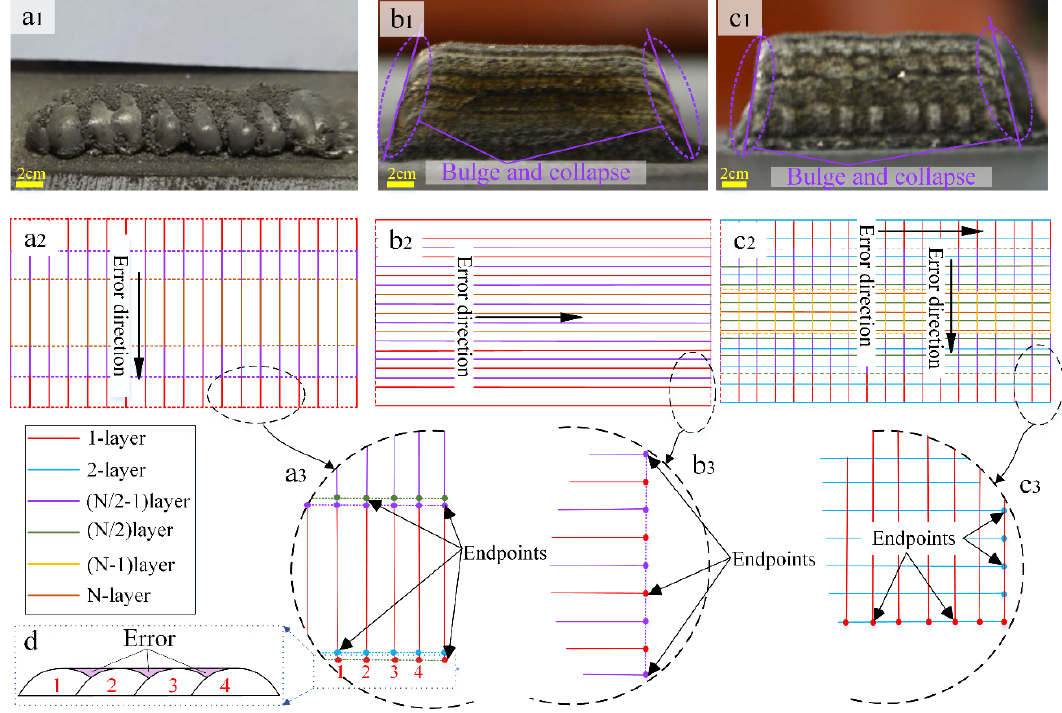
Figure 12. Morphologies of deposition layers under different deposition strategies: ( a ) Strategy III- 1, ( b ) Strategy III-2, ( c ) Strategy III-3, ( d ) Errors owing to incomplete filling. ( b ) Strategy III-2, ( c ) Strategy III-3, ( d ) Errors owing to incomplete